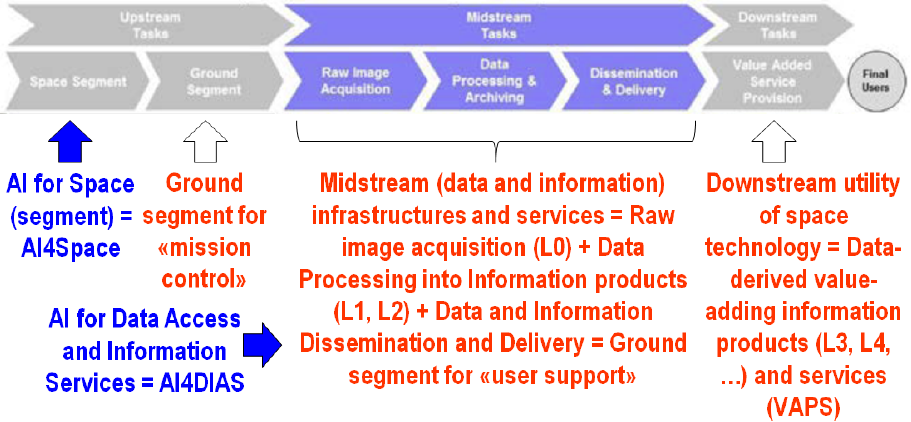
Figure 8. Definitions adopted in the notion of Space Economy 4.0: space segment, ground segment for «mission control» = upstream, ground segment for «user support» = midstream (infrastructures and services), downstream utility of space technology [66] (pp. 6, 57). Cable of transforming quantitative (unequivocal) big data into qualitative (equivocal) data-derived value-adding information and knowledge, AI technologies should be applied as early as possible to the “seamless innovation chain” needed for a new era of Space 4.0, starting from AI4Space applications at the space segment, which include the notion of future intelligent EO satellites (FIEOS) [144,145], and AI4DIAS applications at midstream, such as systematic ESA EO Level 2 product generation, considered synonym for Analysis Ready Data (ARD) eligible for use at